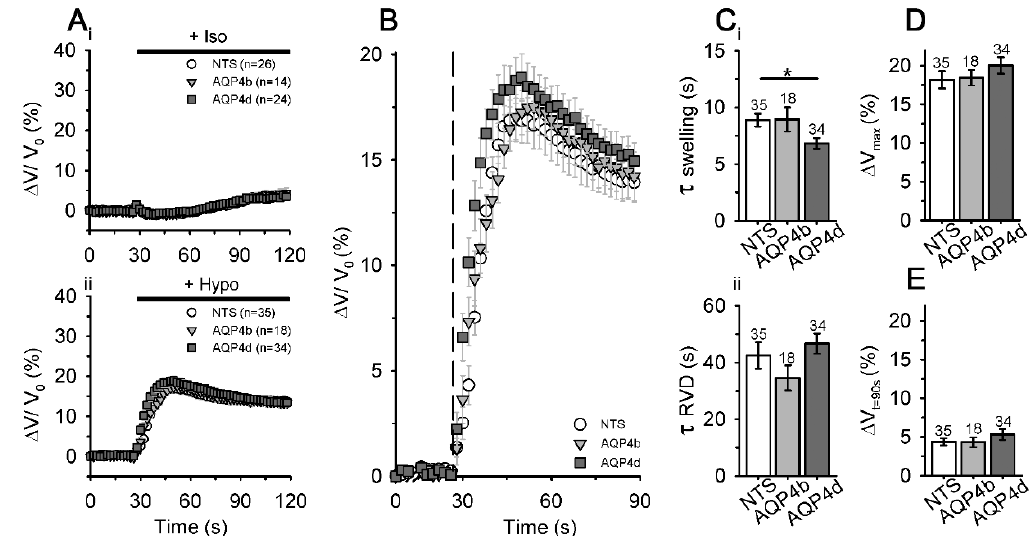
Figure 6. Astrocytes overexpressing AQP4d swell faster in hypoosmotic conditions. ( A ) The average relative volume changes, obtained by measuring the average fluorescence intensity of sulphorhodamine 101 (SR101) in non-transfected (NTS) astrocytes, and in astrocytes overexpressing AQP4b or AQP4d in isoosmotic (Iso; A i ) and hypoosmotic (Hypo; A ii ) conditions. ( B ) The expanded section of the graph shown in A ii represents the swelling phase ( ∆ V / V 0 ) in astrocytes after hypoosmotic stimulation (the addition of hypoosmotic stimulation is represented by the dashed line). ( C i ) The swelling phase ( τ swelling) was faster in cells overexpressing AQP4d than in NTS cells ( p < 0.05, Kruskal–Wallis test, followed by Dunn’s method), whereas in cells overexpressing AQP4b, the swelling phase was similar to that in NTS cells ( p > 0.05, Kruskal–Wallis test, followed by Dunn’s method). ( C ii ) Time constants of the regulatory volume decrease (RVD) phase were similar for NTS cells and cells overexpressing AQP4b or AQP4d ( p = 0.17, Kruskal–Wallis test). ( D ) Maximal amplitude of the volume increase ( ∆ V max ) and ( E ) recovery of the cell volume at 90 s ( ∆ V t = 90s ) in the RVD phase were similar for NTS cells and cells overexpressing AQP4b or AQP4d ( p = 0.44 and p = 0.77, respectively, Kruskal–Wallis test). Data represent means ± standard error of the mean from independent experiments equal to the number of animals: 6 (NTS), 3 (AQP4b), and 4 (AQP4d). The numbers above the bars represent the number of cells analysed.